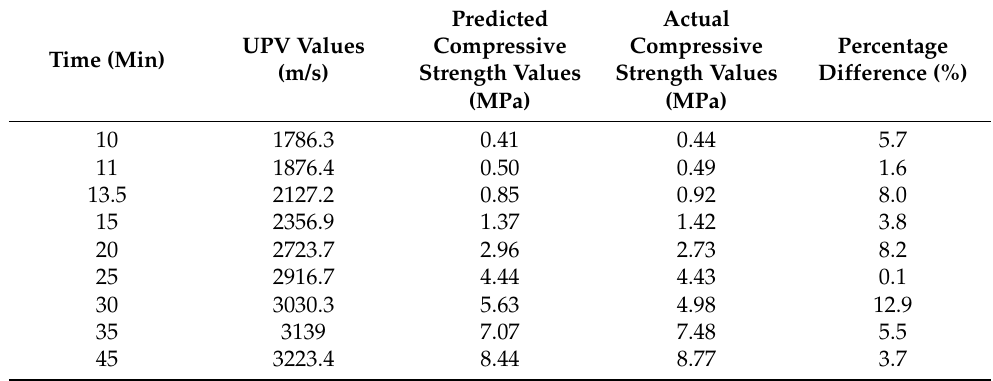
Table 4. The predicted and actual compressive strength values with their corresponding UPV values. Time (Min)